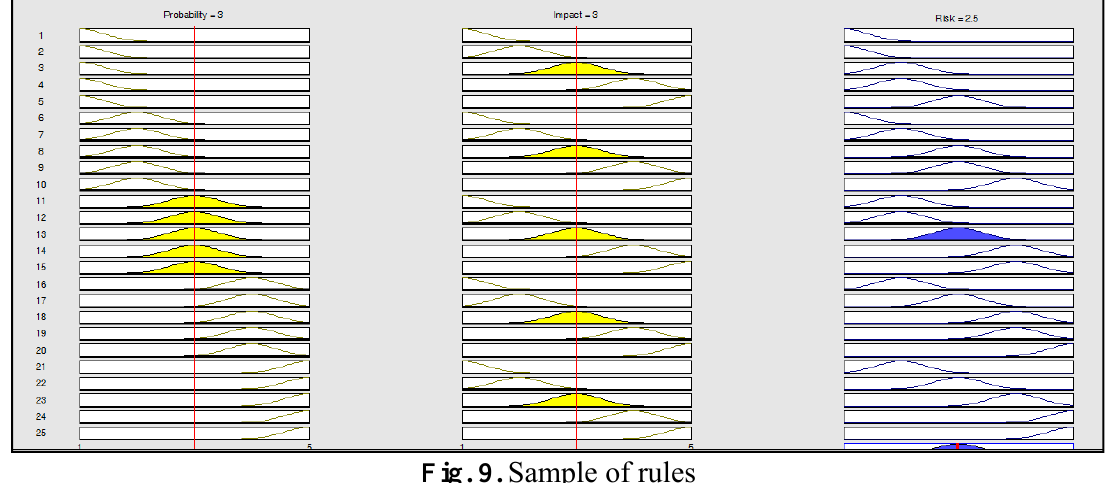
Fig. 9. Sample of